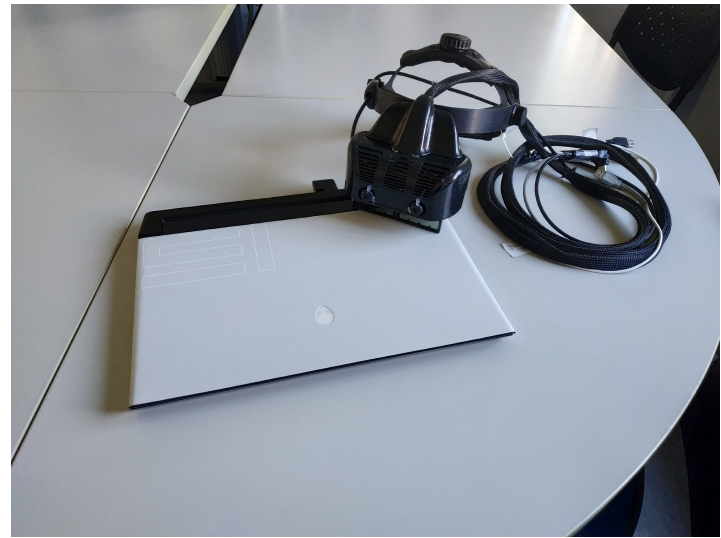
Figure 2. The custom-made hybrid optical/video see-through head-mounted display and the